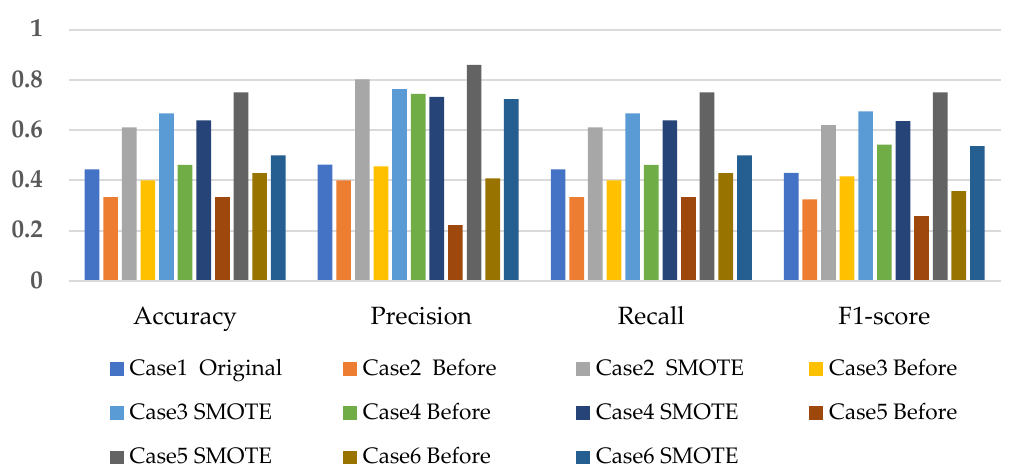
Figure 14. Experimental performance of NBC classification with SMOTE.